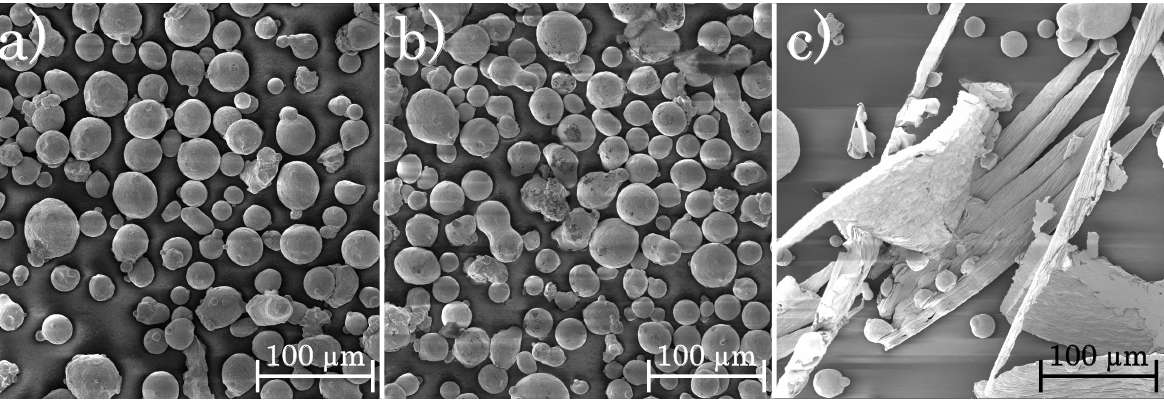
Figure 4. SEM images of ( a ) new, ( b ) recycled and ( c ) oversize